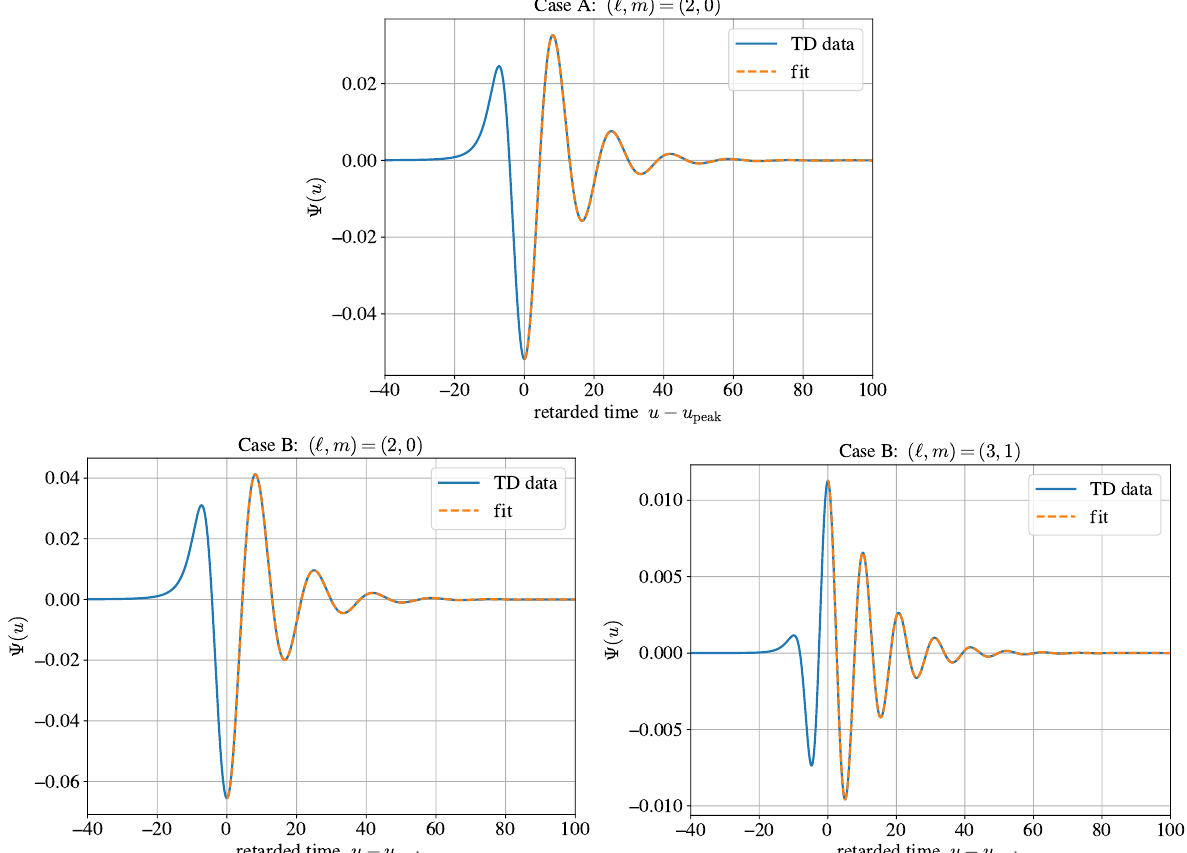
Figure 3. TD data of the Zerilli-Moncrief functions Ψ (cid:96) m with the 2PN close-limit initial data for the head-on collision (the blue solid lines) and QNM fitting with N = 7 in Equation (37) (the orange dashed lines). The TD data is extracted as a function of the retarded time, u , on the v = v f = 3000 M surface. The ( top panel) shows the ( (cid:96) = 2, m = 0 ) mode computed for case A. The ( bottom two panel) shows the ( (cid:96) = 2, m = 0 ) mode (left) and the ( (cid:96) = 3, m = 1 ) mode (right) computed for case